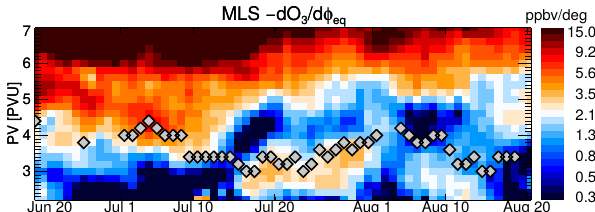
Figure 14. Time evolution of the gradient of ozone from MLS with respect to monsoon equivalent latitude (based on ERA-Interim PV) for June–August 2011 at 380K (note the logarithmic color scale). At each date, MLS measurements from 2 days before to 2 days later have been collected, to yield a sufficient coverage of the monsoon region. Grey symbols show the PV-gradient